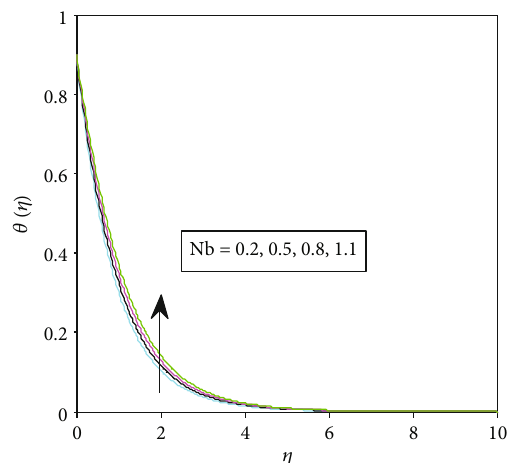
Figure 16: Temperature distribution for di ff erent values of Brownian di ff usion.